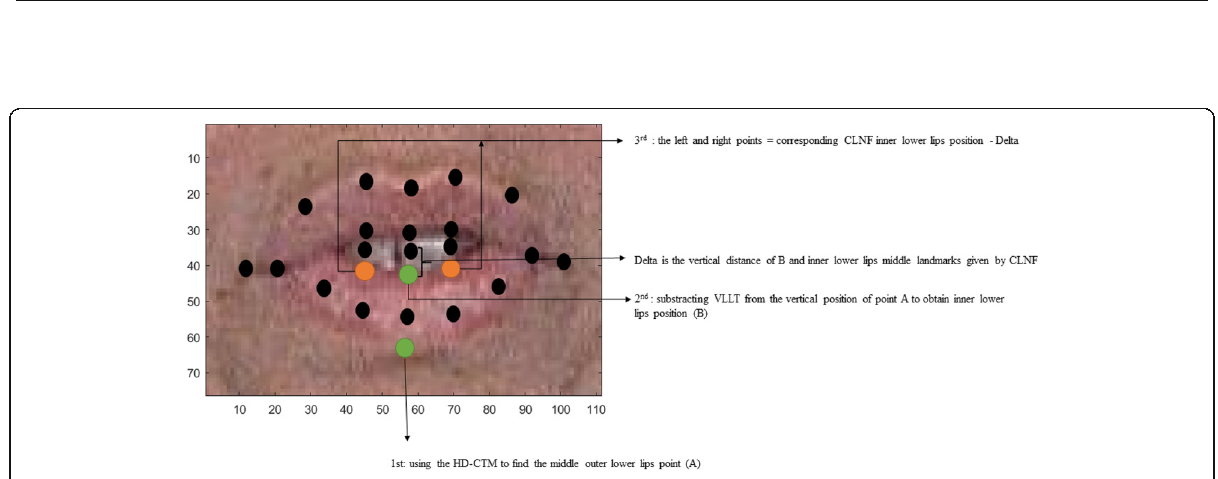
Fig. 8 Twenty black lips landmarks are given by the CLNF with 8 inner lips landmarks. The green point A is the middle outer lower lips position obtained by the HD-CTM and the green point B is the middle inner lower lips position by subtracting the VLLT from the position of A. Two orange points are the left and right key landmarks determined by the third